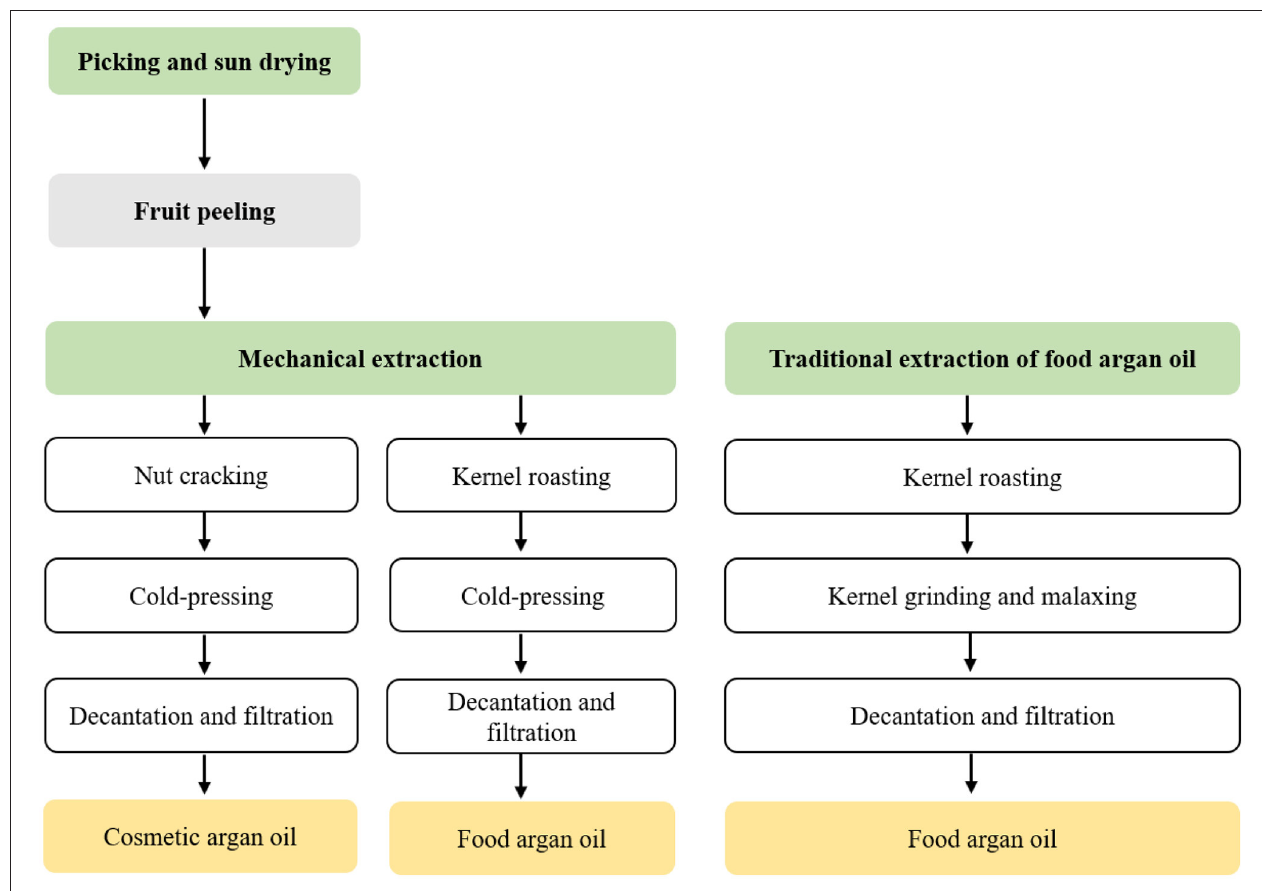
FIGURE 4 | Scheme of argan oil extraction by the pressing